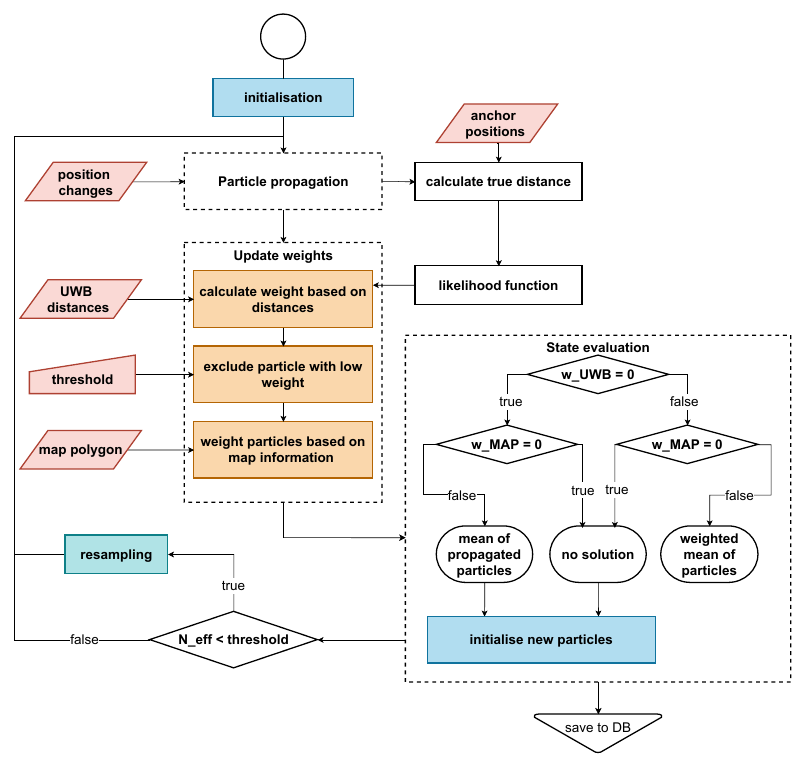
Figure 8. Flowchart of the particle filter